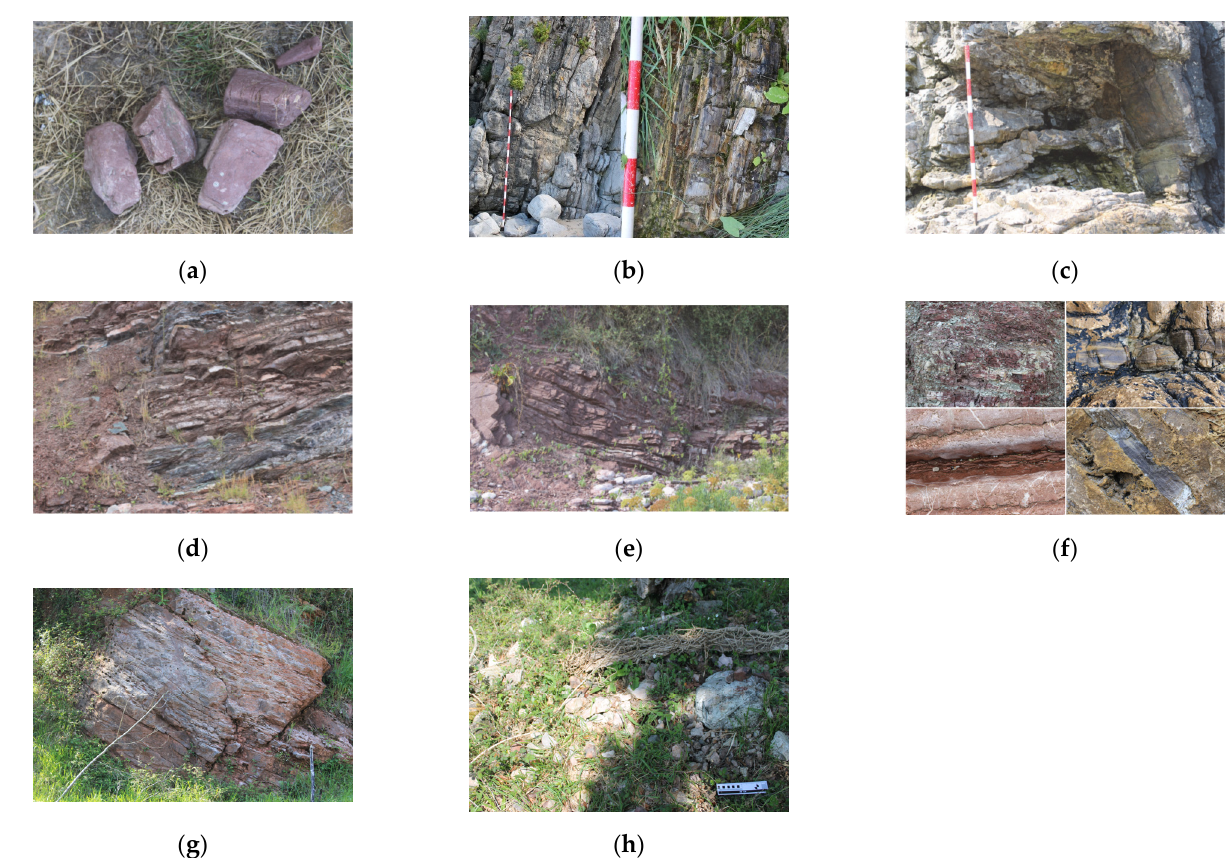
Figure 3. Photos for the investigated chert outcrops: ( a ) Cobijero, ( b ) Pendueles, ( c ) Vidiago, ( d ) La Ballota, ( e ) Andrín, ( f ) San Antolín, ( g ) Arangas, ( h ) Asiego.